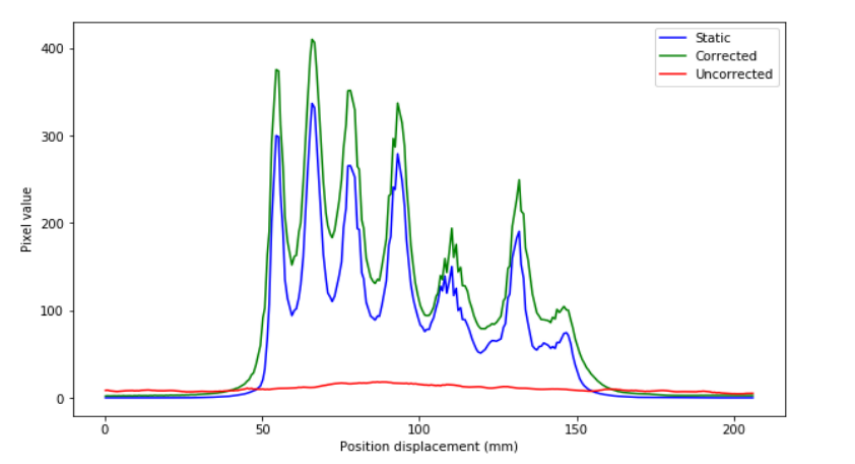
Figure 13. Static, uncorrected, and motion-corrected profiles of 2D motion with the Derenzo phantom. At the quantitative level, the different metrics also show very satisfactory